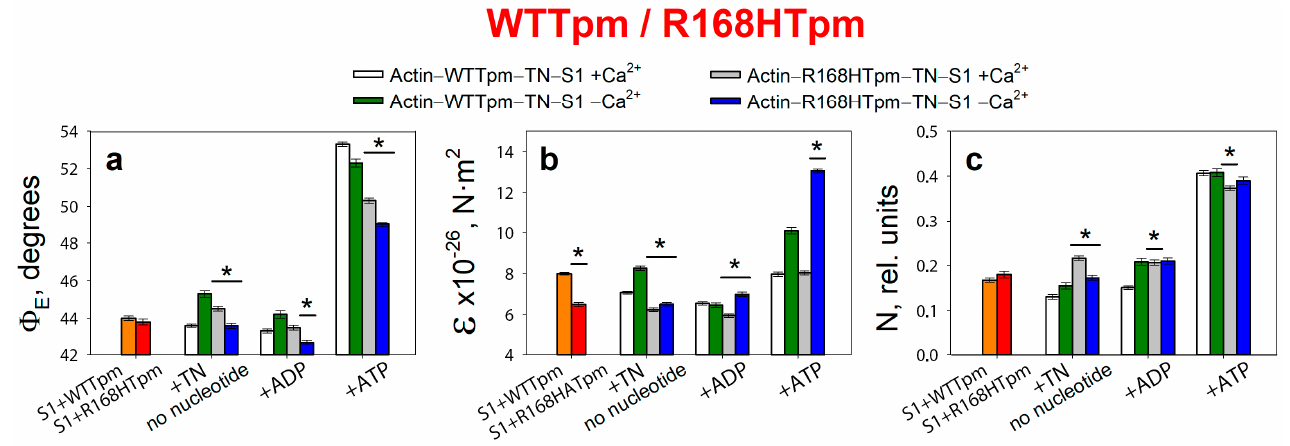
Figure 2. The effect of troponin (TN) and Ca 2+ on the values of Φ E ( a ), ɛ ( b ), and N ( c ) of polarized fluorescence of S1-AEDANS in the presence of WTTpm or R168HTpm was revealed in ghost fibers under conditions of simulating the sequential steps of the actomyosin ATPase cycle. The data are averages for 4–6 fibers for each experimental condition. The data are presented as mean ± SEM. * p < 0.05 = difference between WTTpm and R168HTpm.